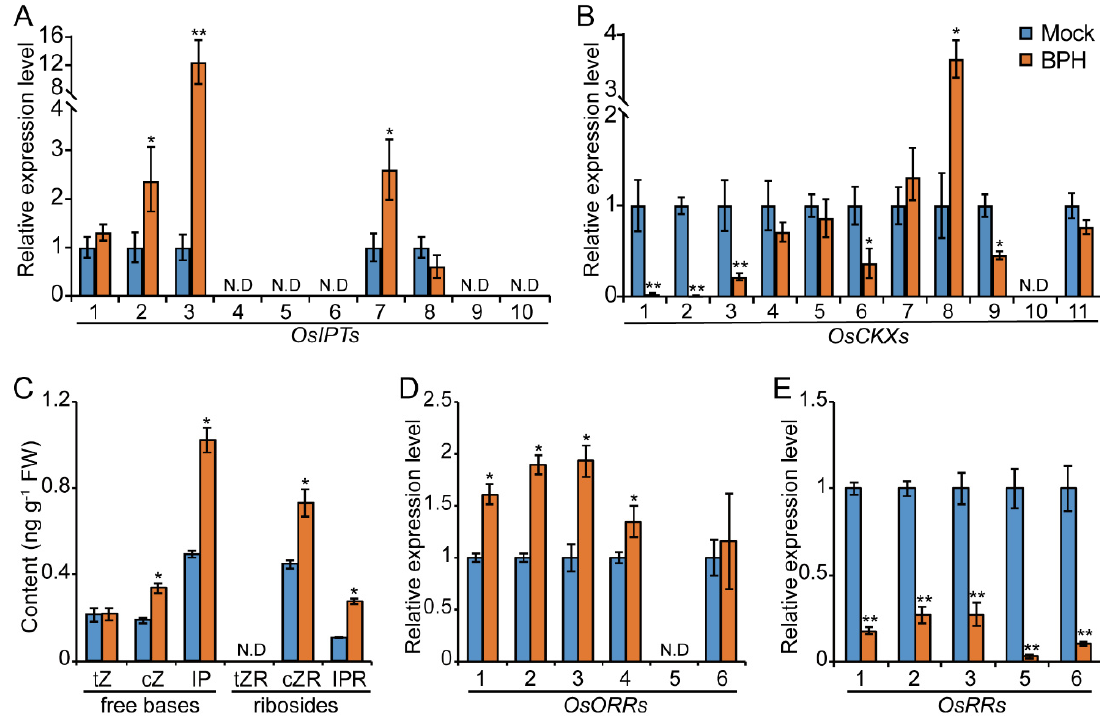
Figure 1. BPH infestation activates the CK pathway in rice. ( A , B ) qRT-PCR analysis of transcript levels of CK metabolic genes OsIPT s and OsCKX s in BPH-infested and non-infested rice seedlings. The expression levels of genes in non-infested rice seedlings were set as 1. Ubiquitin ( Os03g0234350 ) was used as an internal reference. ( C ) Levels of endogenous CKs in BPH-infested and non-infested rice seedlings measured by nano-LC-ESI-Q-TOF-MS. tZ, trans-zeatin; cZ, cis-zeatin; iP, isopentenyl- adenine; tZR, cis-zeatin riboside; cZR, cis-zeatin riboside; iPR, isopentenyladenine riboside. ( D , E ) Transcript levels of type-B CK response regulators, OsORR s, and type-A CK response regulators, OsRR s. Sheaths from ten-day-old seedlings of Zhonghua11 were collected at 24 h after BPH feeding for qRT-PCR analysis and CK quantification. N.D indicates undetected. Data are shown as mean ± SD, n = 3. Statistical differences were determined by two-tailed Student’s t -test, * p < 0.05, ** p < 0.01.